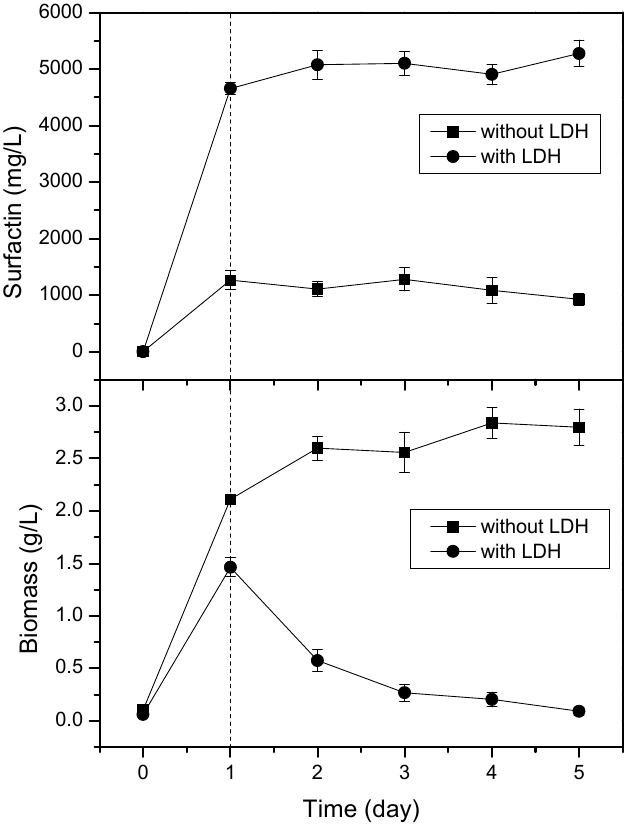
Figure 4. Time courses of surfactin and biomass production in the presence and absence of Mg 2 Fe–LDH (4 g / L). Error bars indicate the standard deviations from three tests.